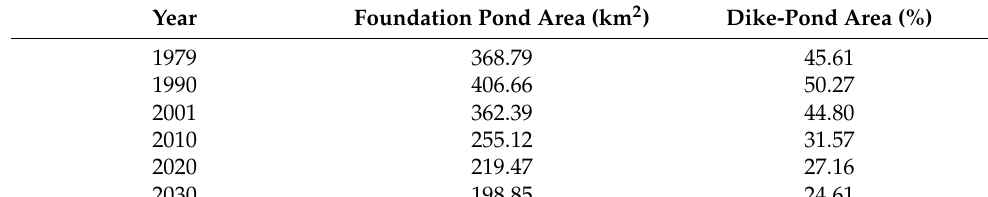
Table 6. Area and proportion of dike-ponds in the study area from 1979 to 2030.